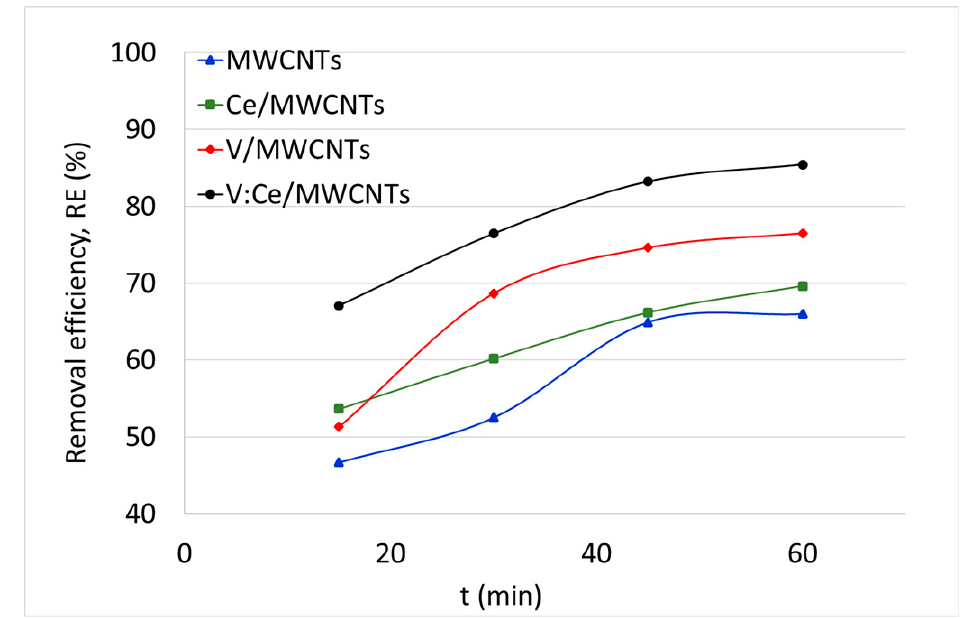
Figure 9. Removal efficiency of kerosene from water against time over MWCNTs, Ce/MWCNTs, V/MWCNTs, and V:Ce/MWCNTs ( C 0 = 500 mg, V sample = 0.05 L, m ads = 0.005 g).